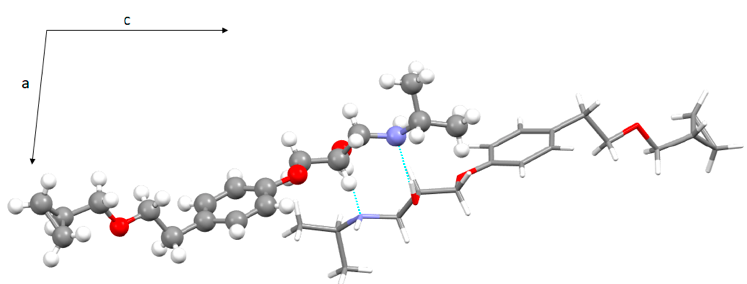
Figure 6. View of the H-bond network in the crystal packing of BE_I along the b axis direction (S enantiomer in ball and stick, R enantiomer in stick). For sake of clarity only the set of coordinates having the highest occupancy factor was shown.